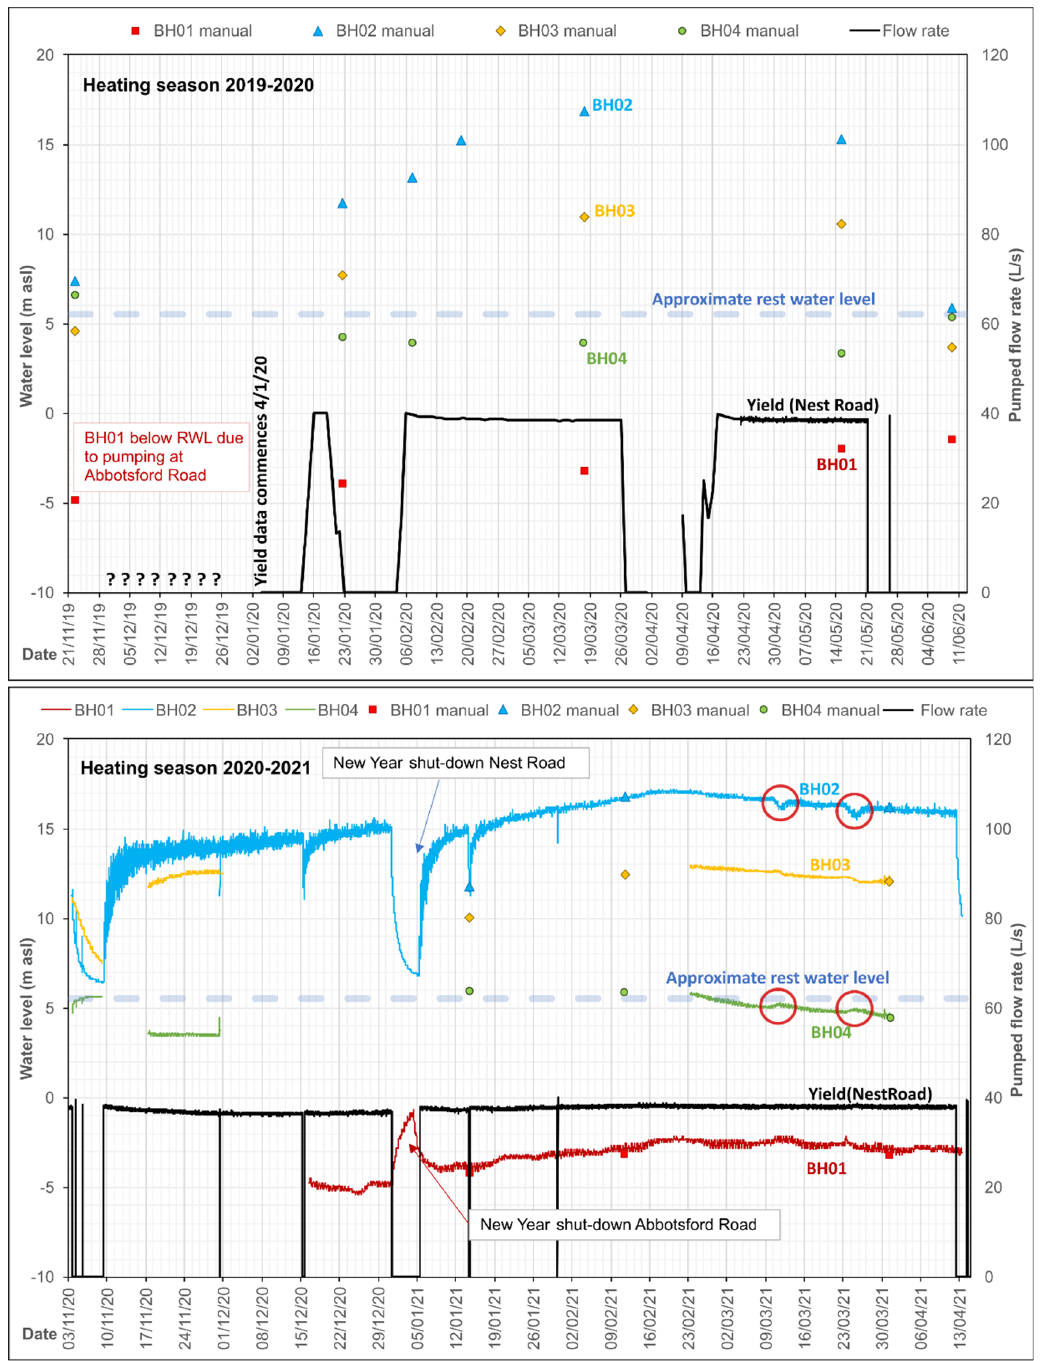
Figure 9. Hydrographs from operation of the Nest Road scheme during the periods November